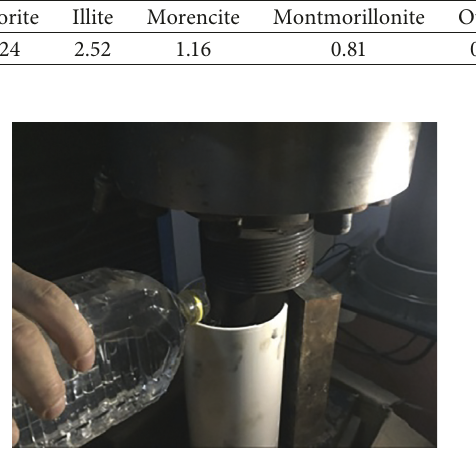
Table 2: The percentage of mass of various minerals in the red mudstone.